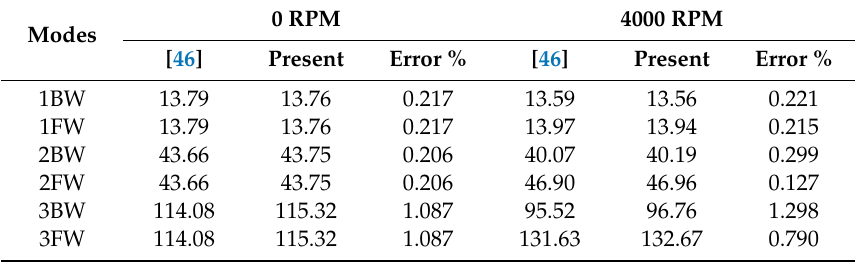
Table 5. Backward and forward whirl (BW and FW) frequencies of a steel double-disc rotor.